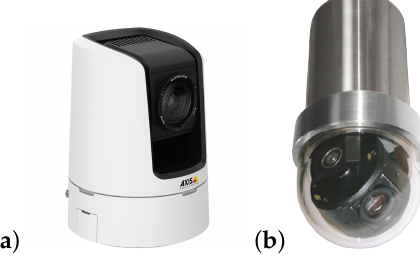
Figure 11. Cameras PTZ: ( a ) Axis V5914 PTZ, usually attached on the CERNBot platform. ( b ) Bowtech BP-DTR-100-Z underwater camera for further use in radioactive dust and underwater